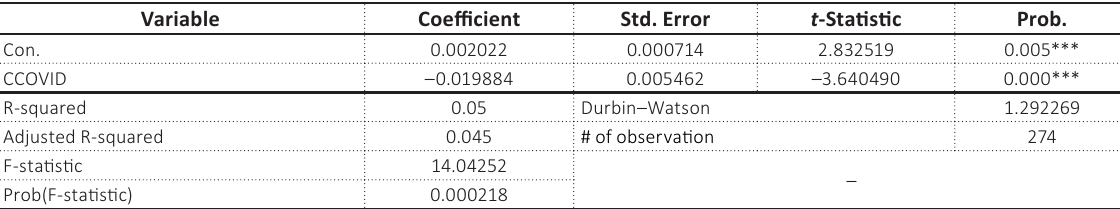
Table 5. General market index and confirmed cases of COVID-19